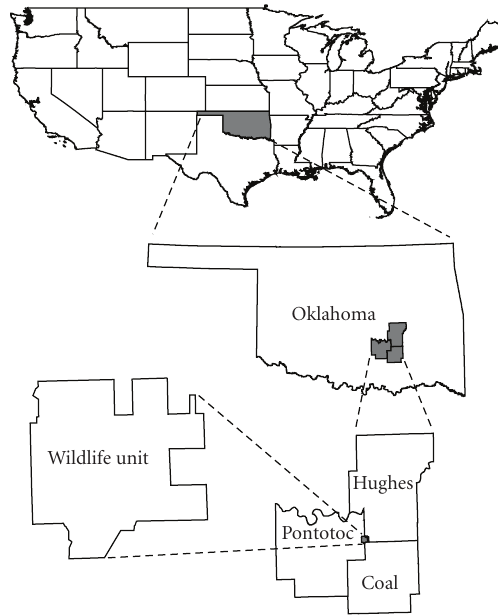
Figure 1: Samuel Roberts Noble Foundation Wildlife Unit located in Coal, Hughes, and Pontotoc Counties, Oklahoma,